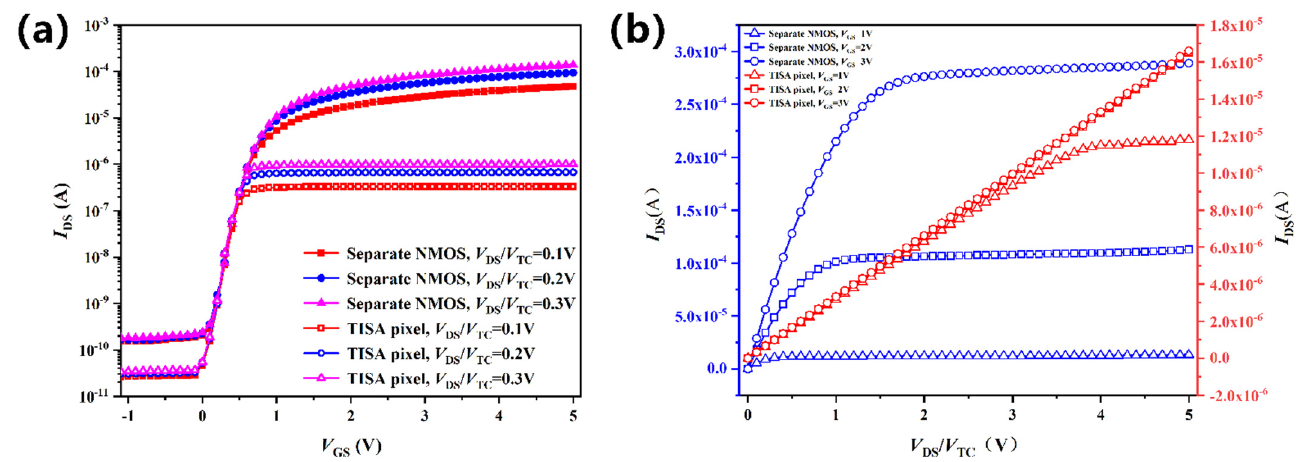
Figure 6. ( a ) I D - V DS / V TC and ( b ) I D - V GS characteristic curves of a TISA pixel and a separate NMOS.